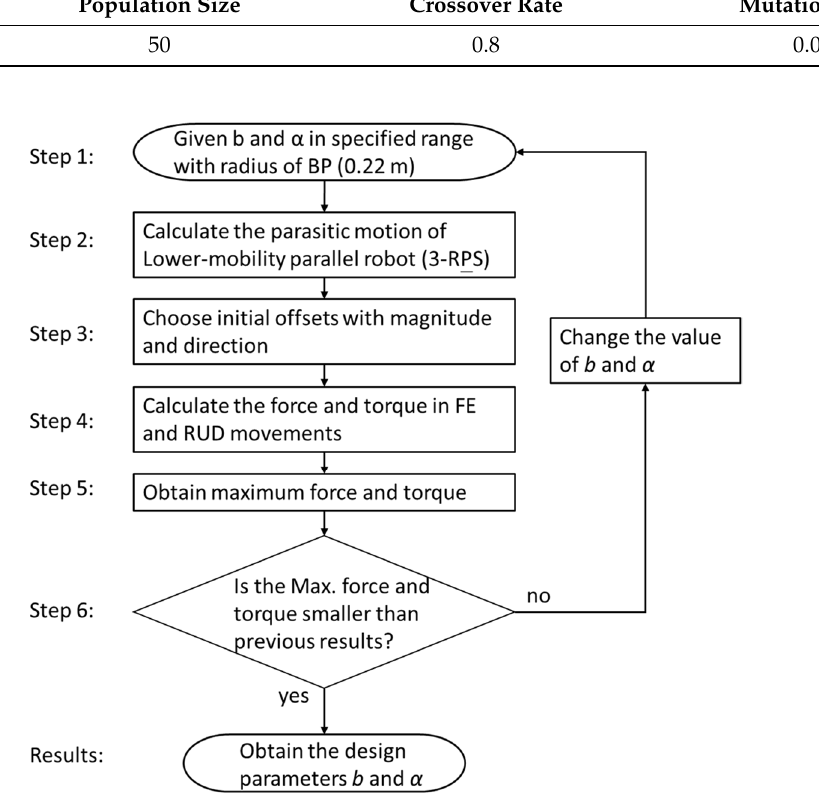
Figure 5. Flowchart of analysis procedure.